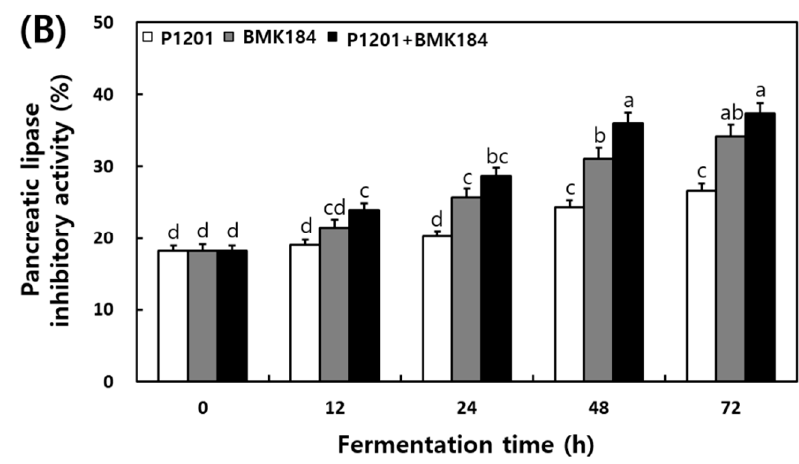
Figure 3. Changes of enzymatic inhibitory effects during the fermentation of isoflavone-enriched soybean leaves (IESLs) with the use of Lactiplantibacillus plantarum P1201 and/or Levilactobacillus brevis BMK184 as starters. Samples: The IESLs were fermented at 35 °C for 72 h, with the use of Lactiplantibacillus plantarum P1201 and/or Levilactobacillus brevis BMK184 as starters. ( A ) α –Glucosidase inhibitory activity and ( B ) Pancreatic lipase inhibitory activity. All values represent the means of the determinations performed in three independent experiments. Different small letters correspond to the significant differences relating to the fermentation time and starter using Tukey’s multiple test ( p < 0.05).